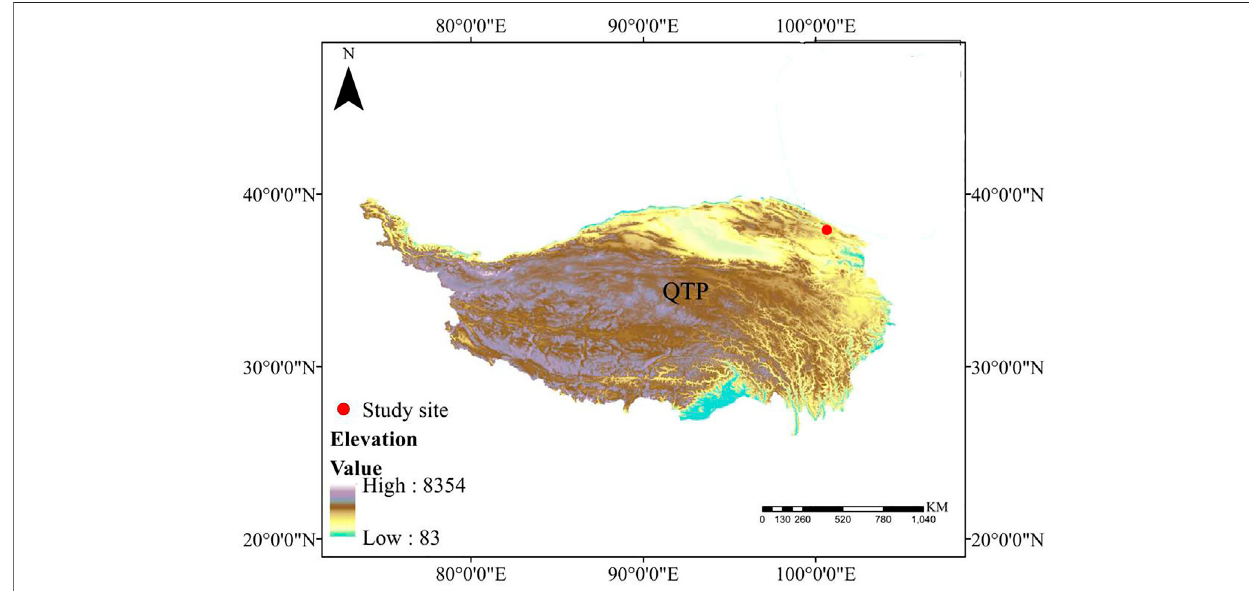
FIGURE 1 | Location map of the study site in this study.